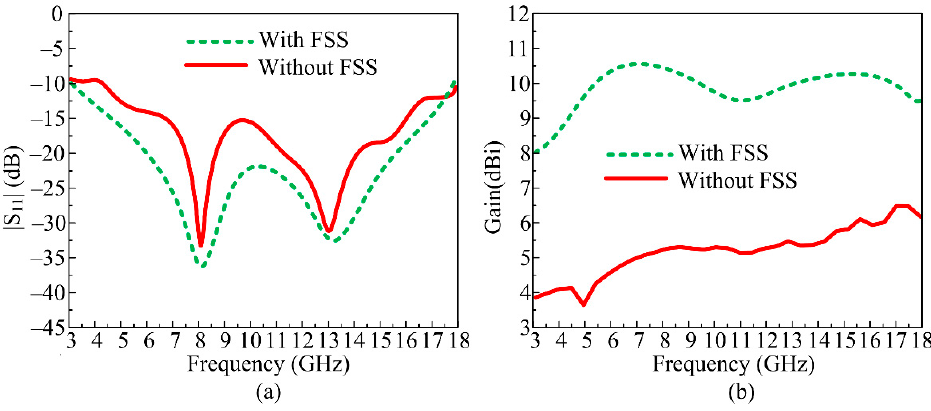
Figure 7. ( a ) Simulated |S 11 | plot of suggested antenna with and without FSS; ( b ) predicated gain of suggested antenna with and without FSS.